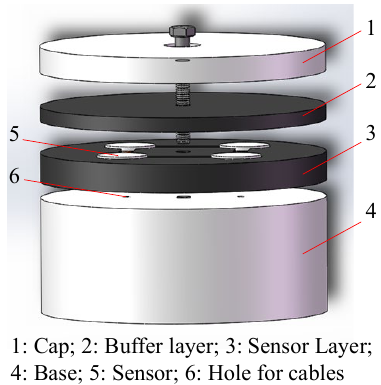
Figure 1. Schematic diagram of a wireless WIM sensor.